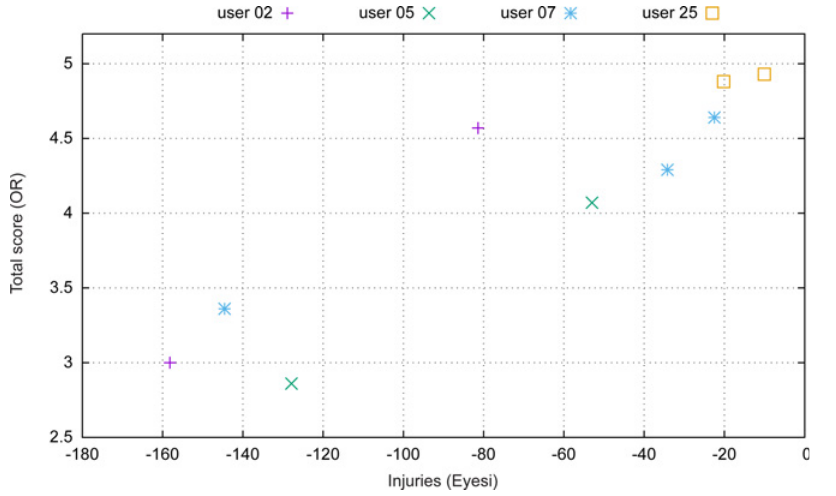
Fig 3. Comparison of injury score in simulation and total operating room score.